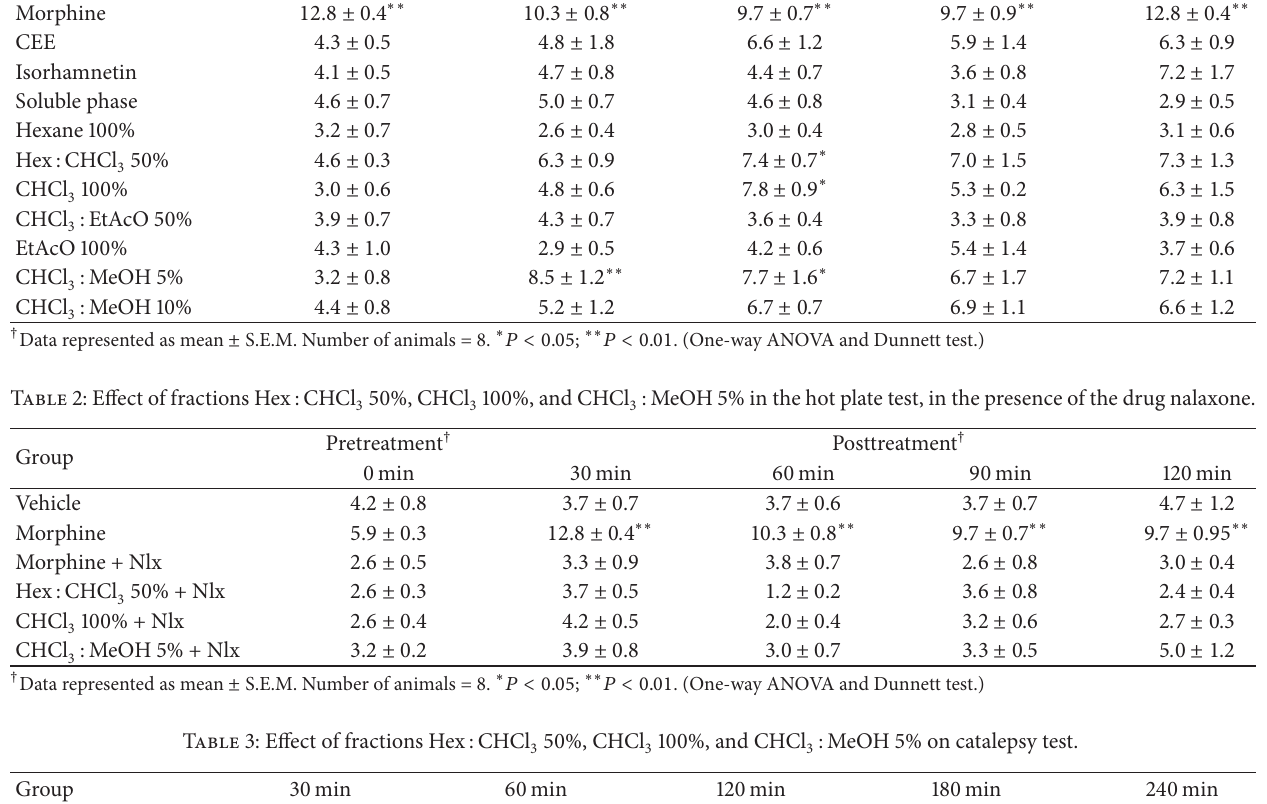
Table 3: Effect of fractions Hex : CHCl